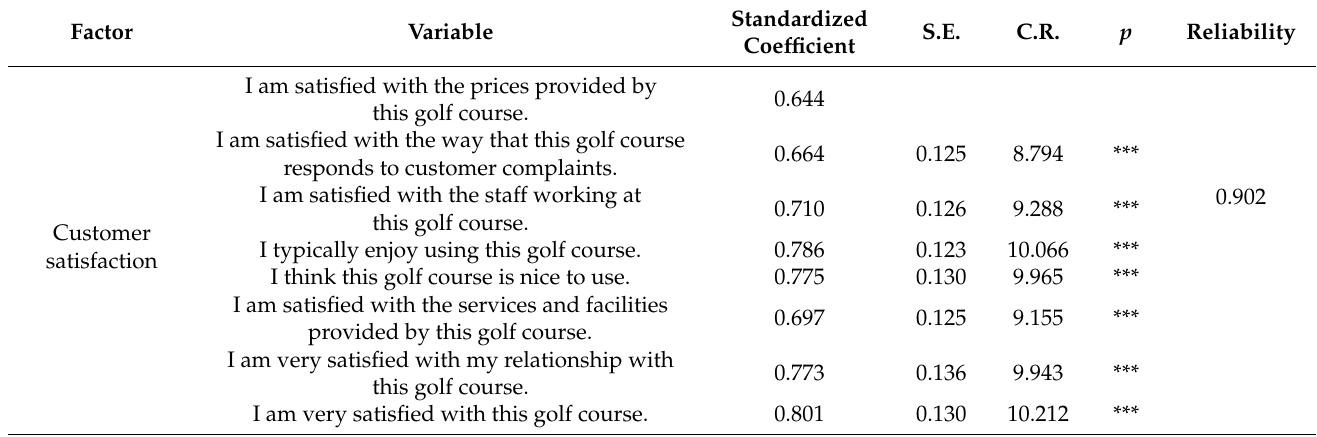
Table 5. The results of validity and reliability analysis for customer satisfaction.